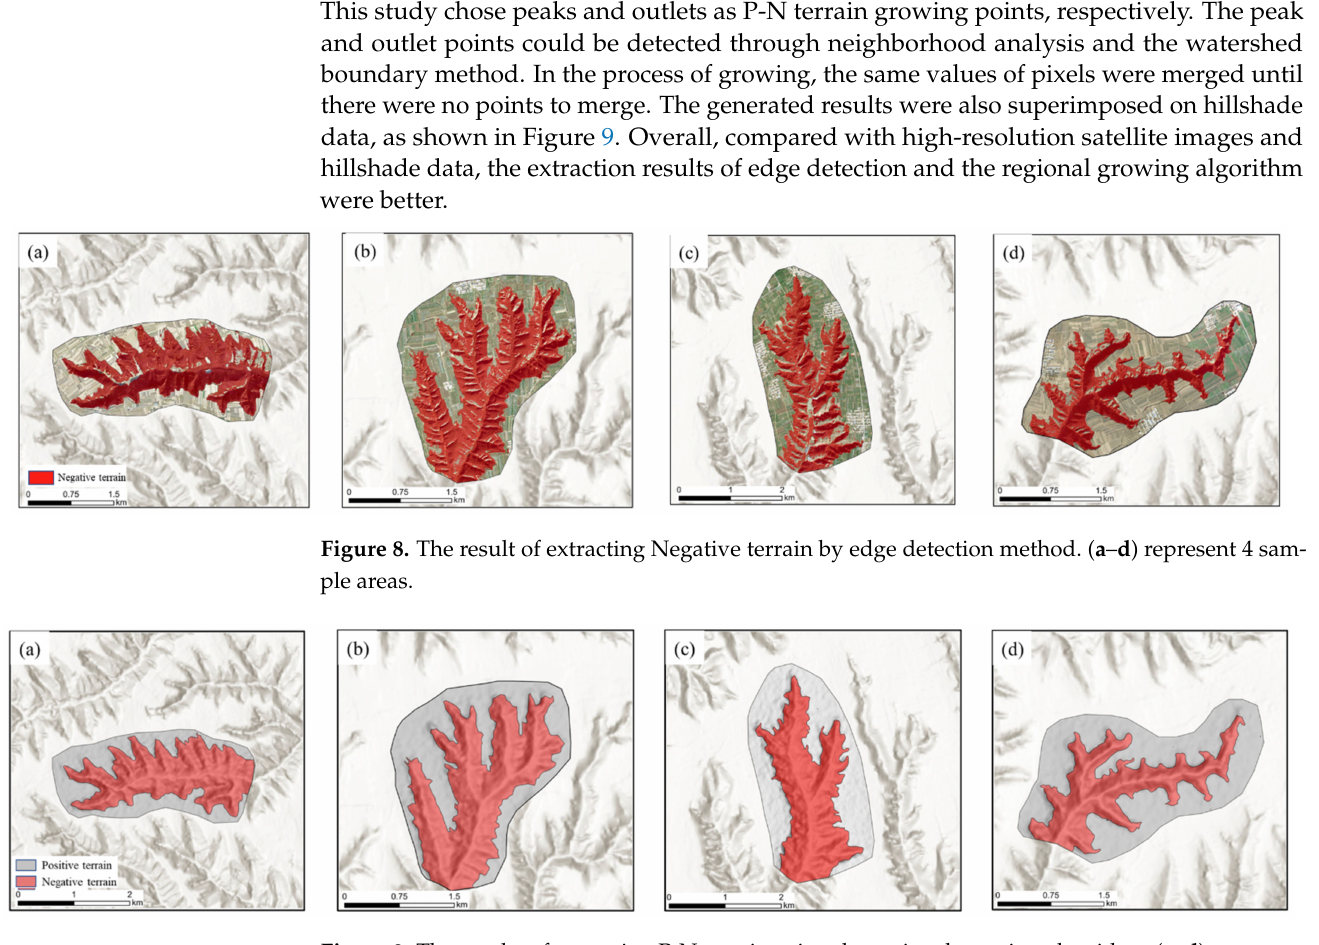
Figure 9. The results of extracting P-N terrain using the regional growing algorithm: ( a – d ) represent 4 sample